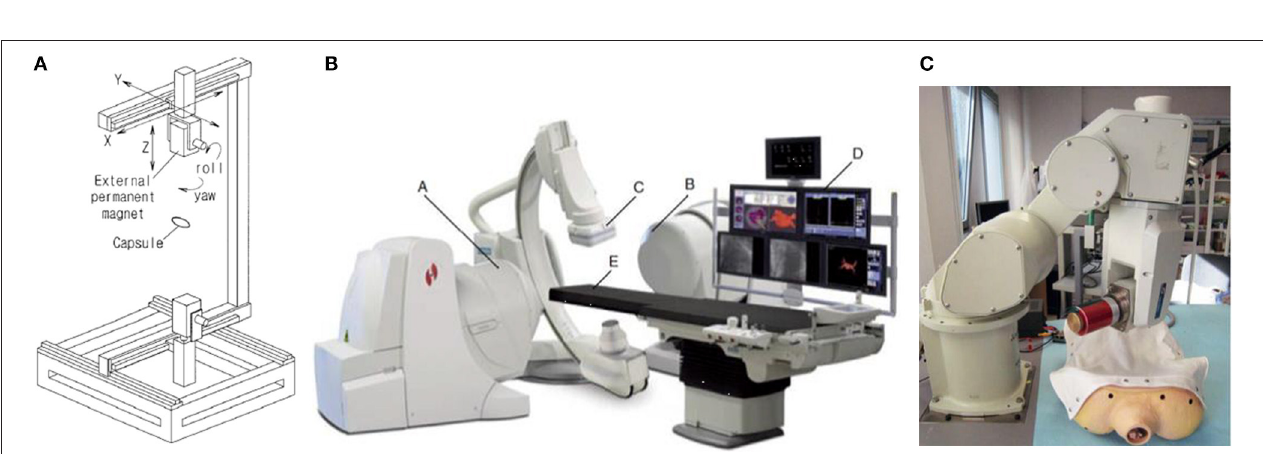
FIGURE 4 | (A) Seven permanent magnets proof mechanism system is used to prove that the maximum 8-DOF magnetic control can be achieved (Salmanipour and Diller, 2018). (B) Magnetic field generation prototype for 8-DOF control, consisting of four inner coils and four outer coils (Salmanipour and Diller, 2018) (C) BatMag control system has 9 electromagnetic coils for 6-DOF control ( Ongaro et al., 2019).